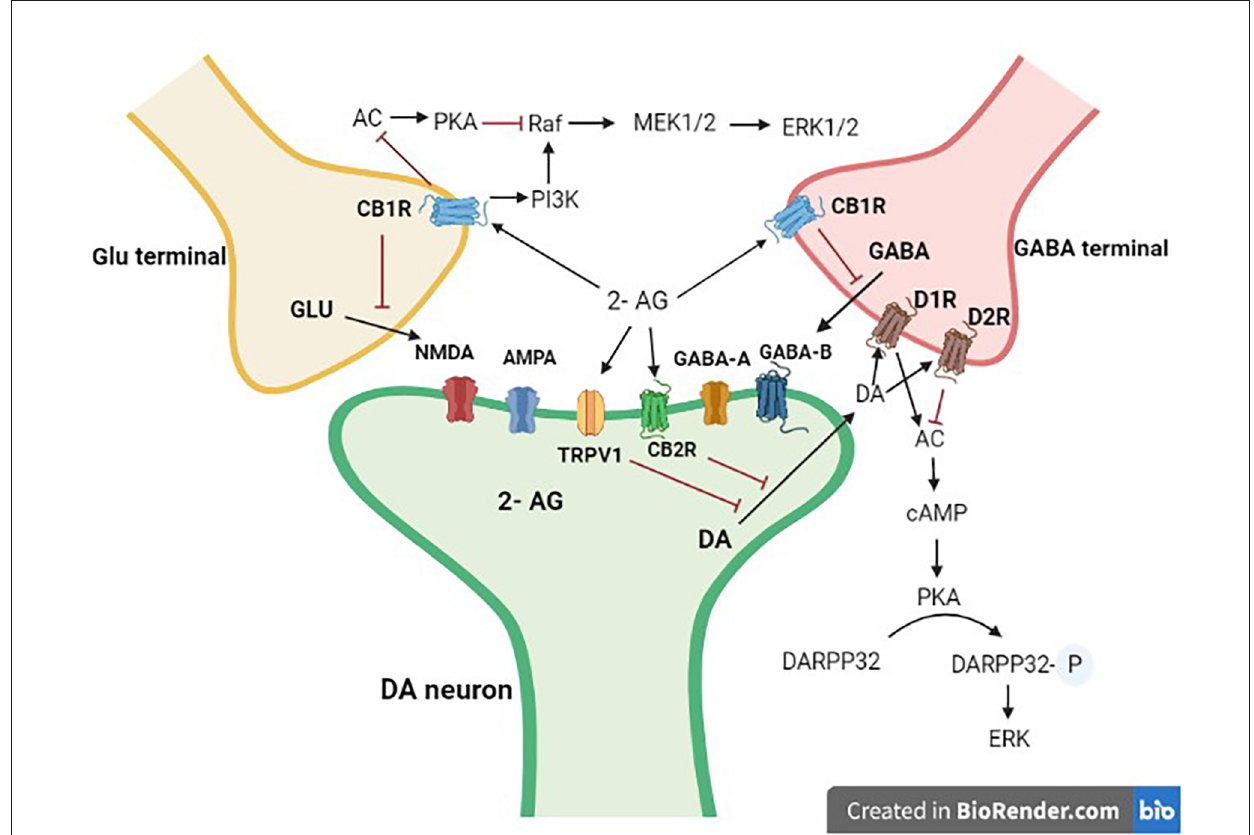
FIGURE3 Interaction of mid-brain dopaminergic neurons with GABA and Glutamate terminals. Dopaminergic projections from the mid-brain VTA and the SN target postsynaptic glutamatergic and GABAergic axon terminals. 2-AG, 2 arachidonoyl glycerol; Glu, glutamate; DA, dopamine; GABA, γ